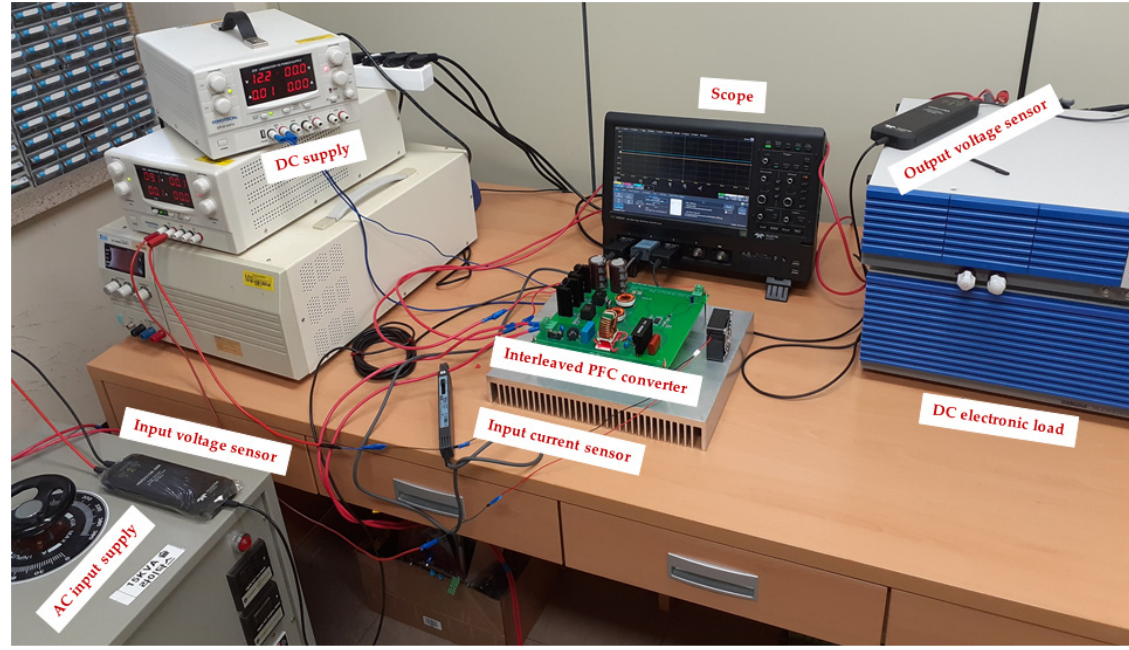
Figure 23. Experimental setup for testing of the designed PFC converters. At the rated input of (220 Vrms, 60 Hz), different loading conditions (25%, 50%, 75%, and 100%) of the full load condition are loaded to the designed converter. Figures 24 and 25 and show the input, output voltages, input current waveforms, and the power factor measurement for the conventional and the interleaved PFC converters,